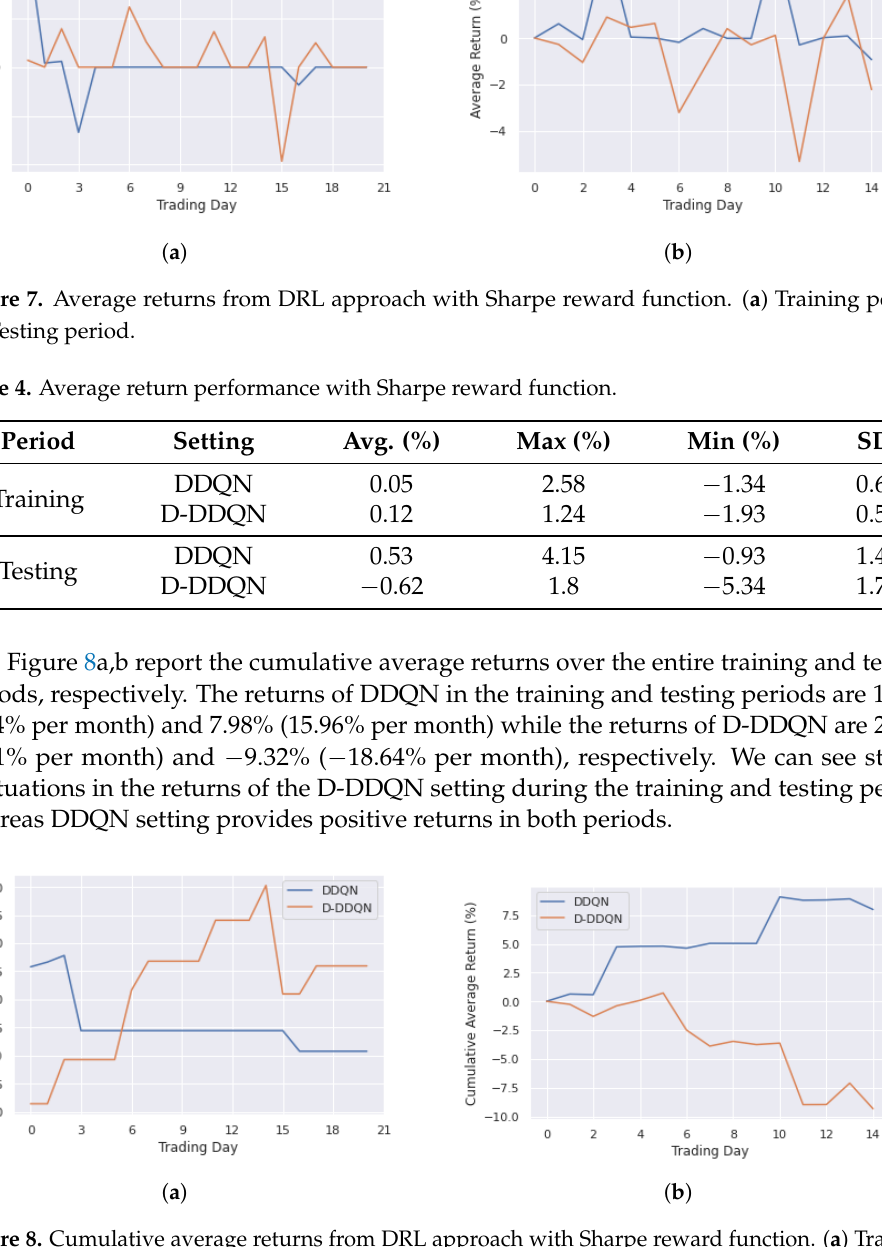
Figure 8. Cumulative average returns from DRL approach with Sharpe reward function. ( a ) Training period; ( b ) Testing